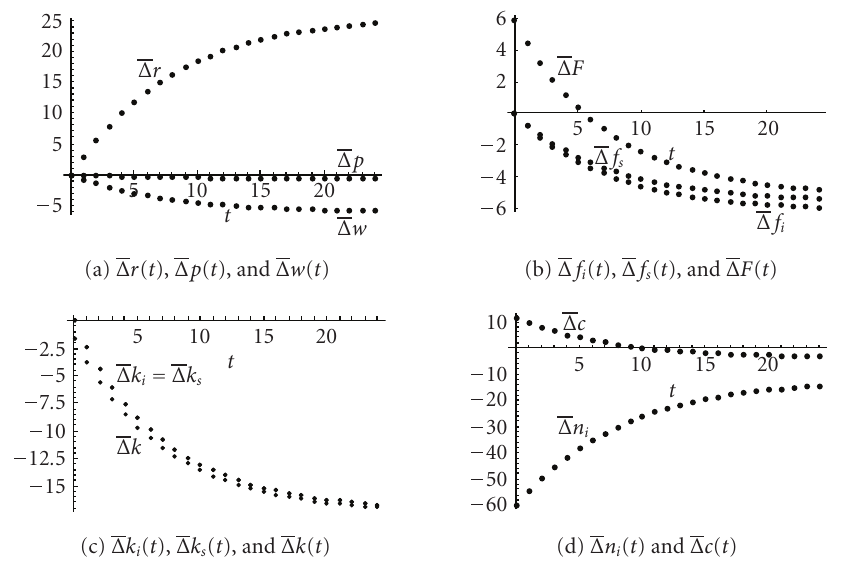
Figure 5.2. A fall in the propensity to